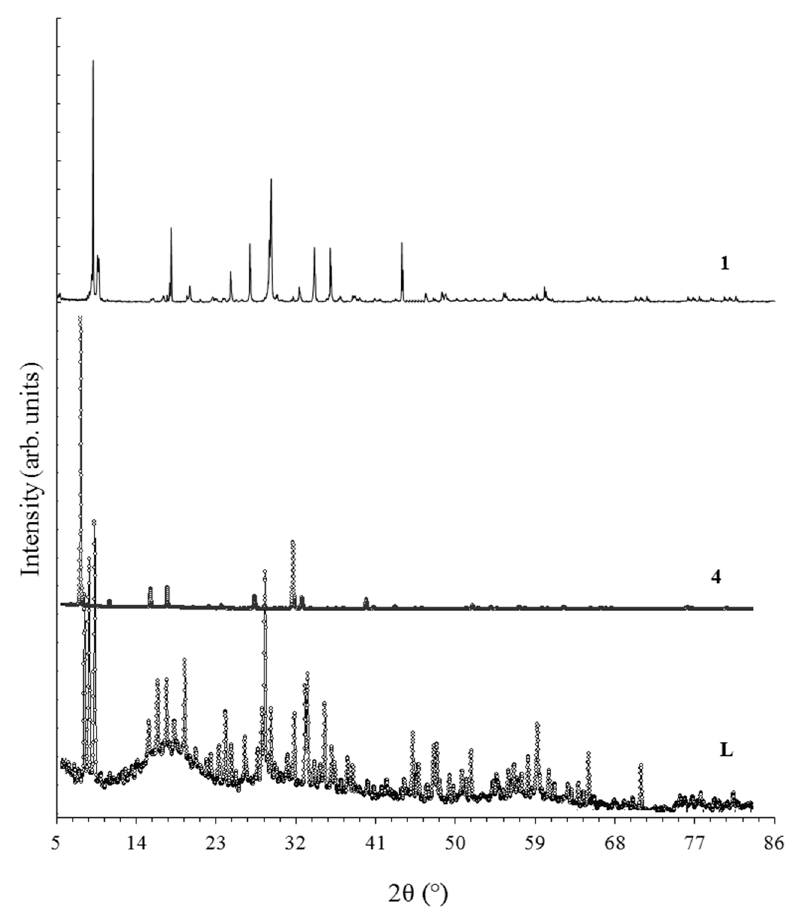
Figure 10. XRD spectra of ligand L and complexes 1 and 4.